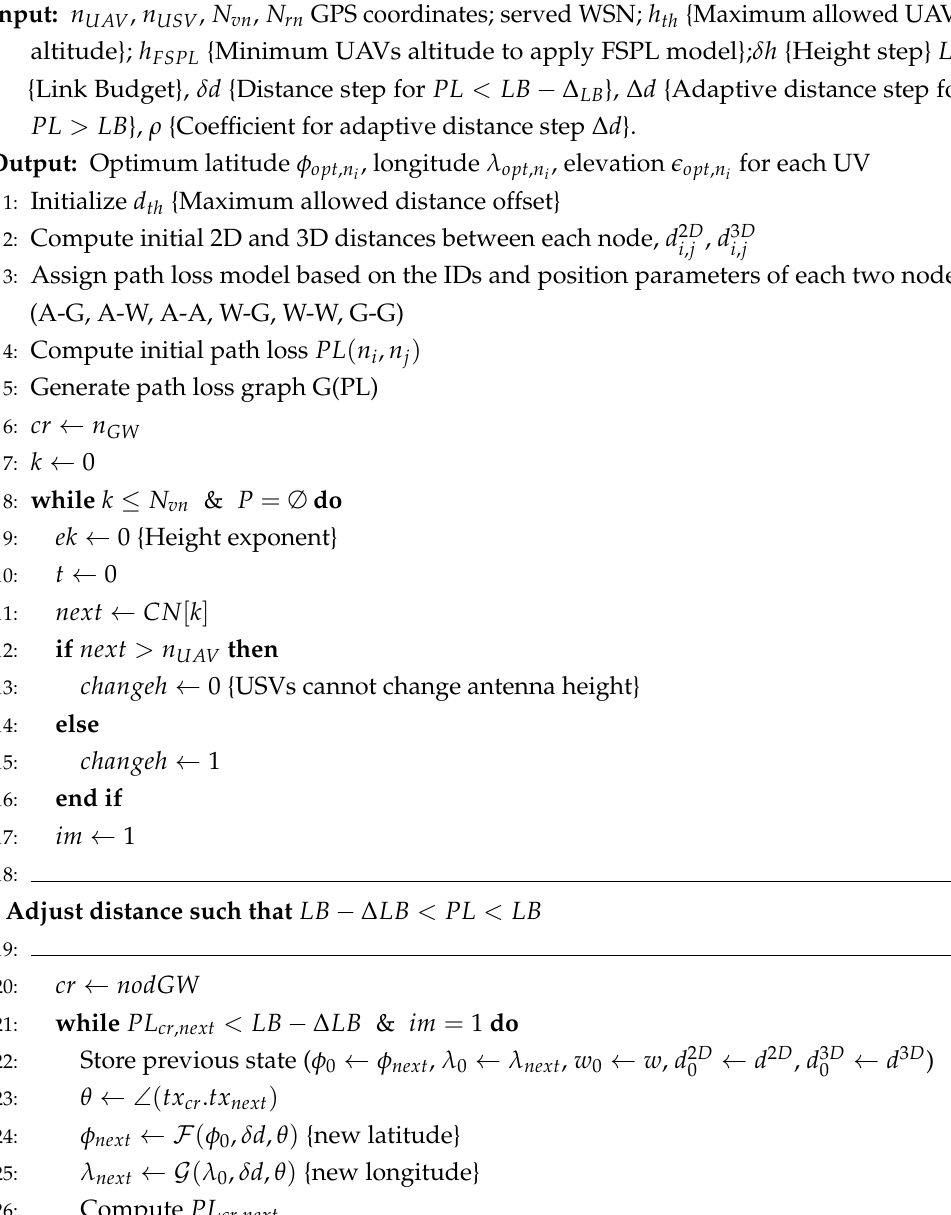
Algorithm 2 Path loss-based placement optimisation